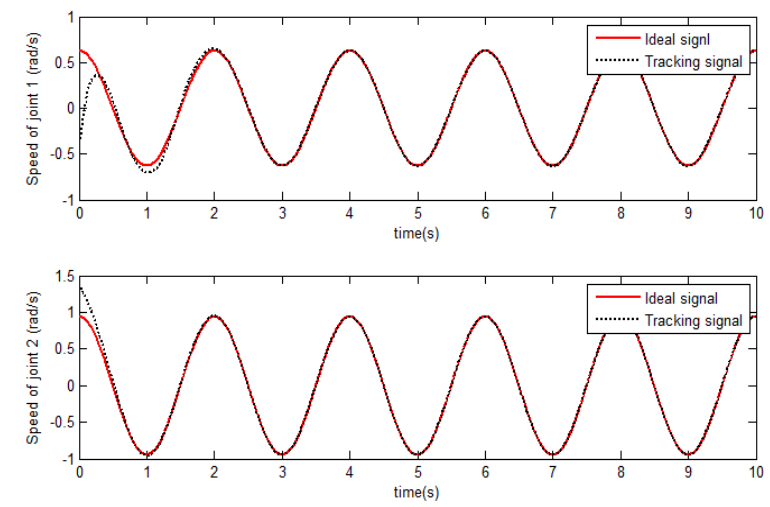
Figure 8. Speed of ARA joint 1 and joint 2.